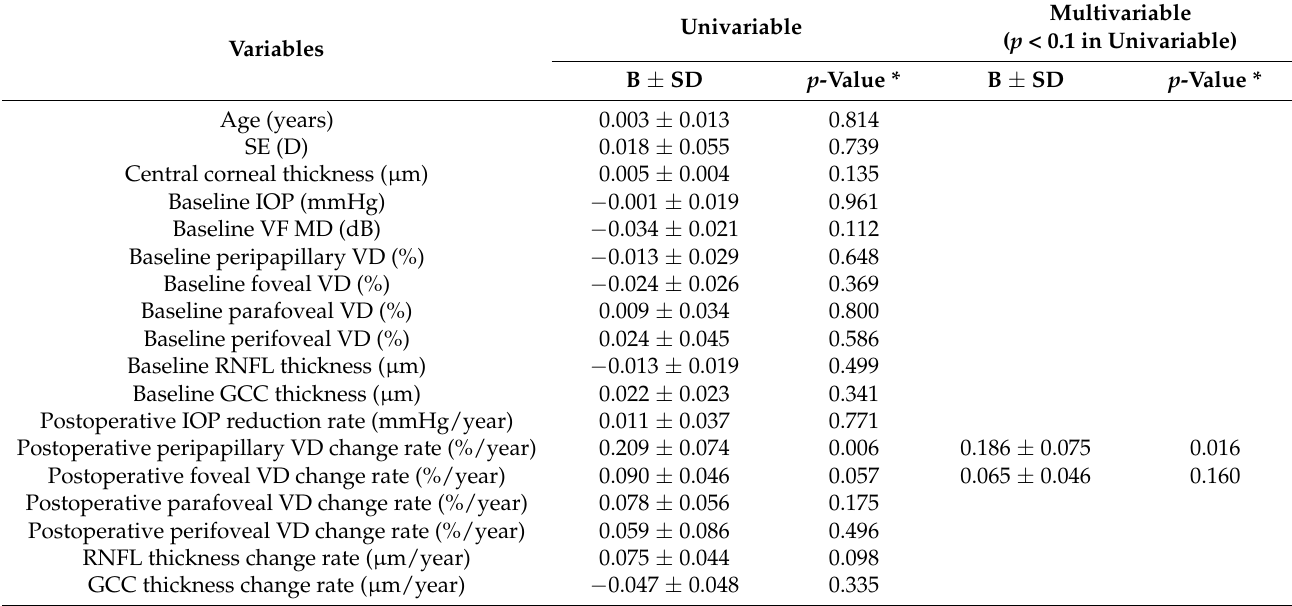
Table 4. Univariable and multivariable linear regression analyses to determine the factors associated with the visual field change rate after trabeculectomy.